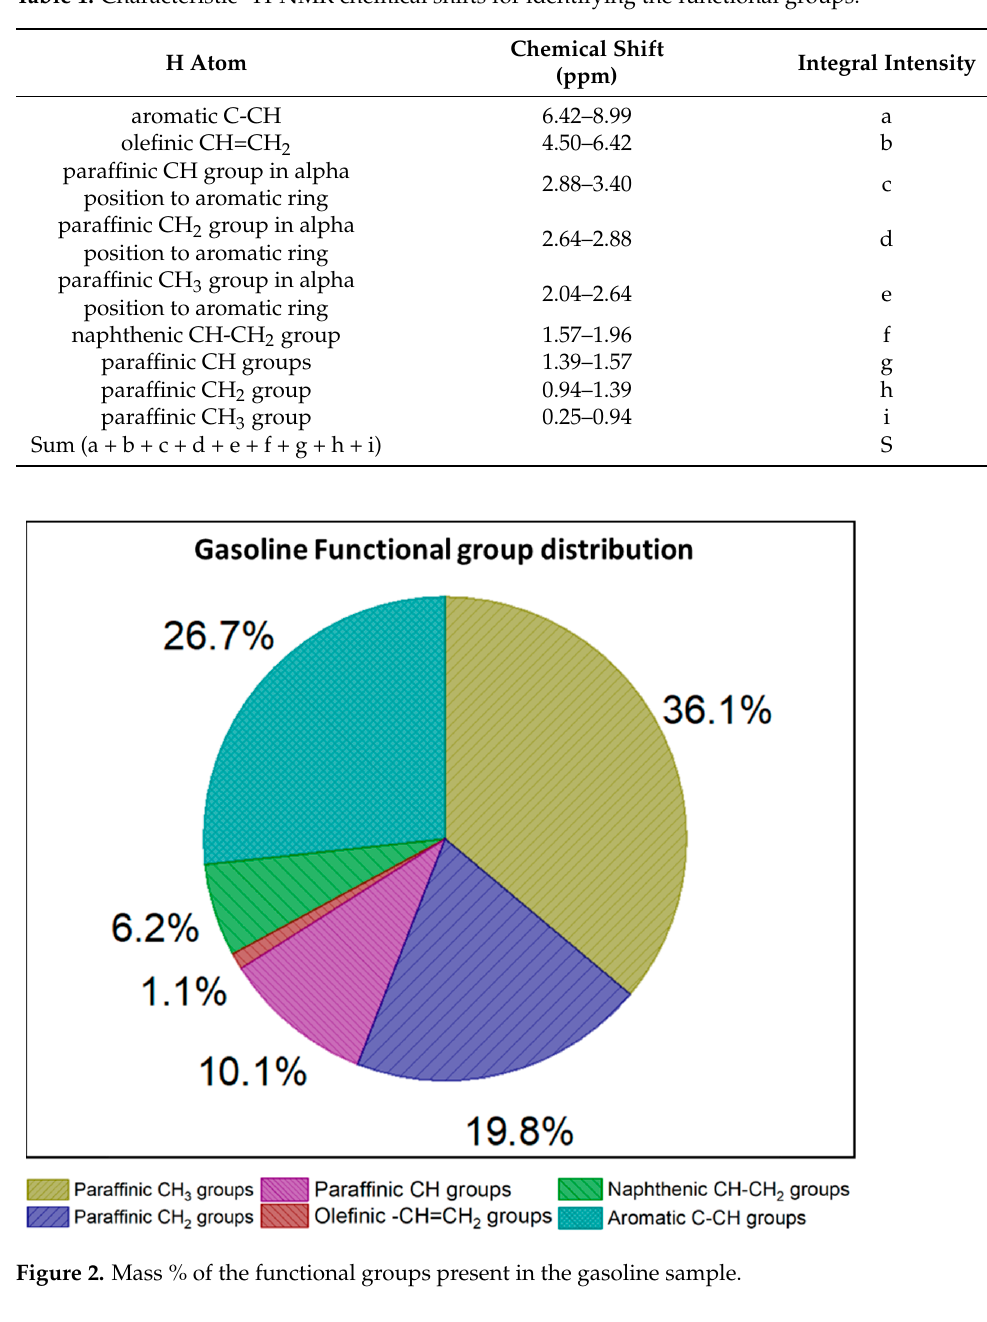
Table 1. Characteristic 1 H-NMR chemical shifts for identifying the functional groups.